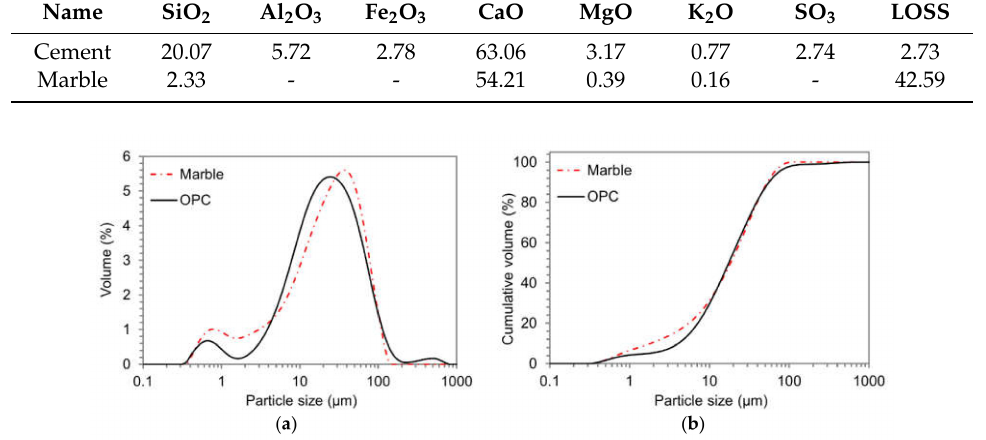
Figure 1. Particle size distribution for marble powder and cement. ( a ) Volume distribution; ( b ) cumulative